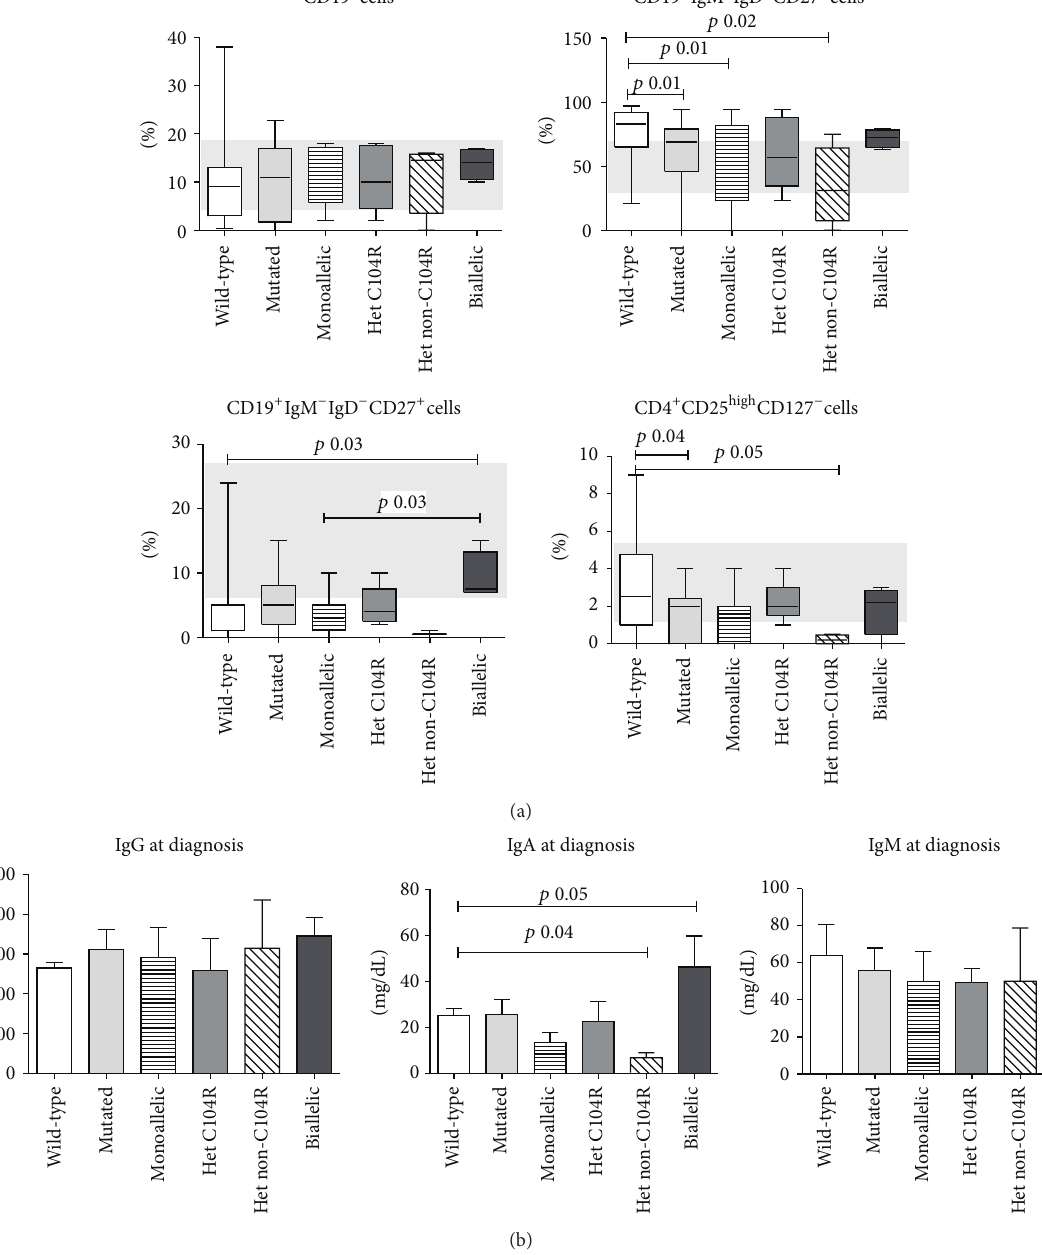
Figure 3: Immunological phenotype (a) and immunoglobulin levels (b) in TACI-deficient individuals and wild-type TACI patients. TACI- deficient individuals were grouped as carrying monoallelic TACI mutations (heterozygous C104R and heterozygous non-C104R) and biallelic TACI mutations. The grey area represents the referral values